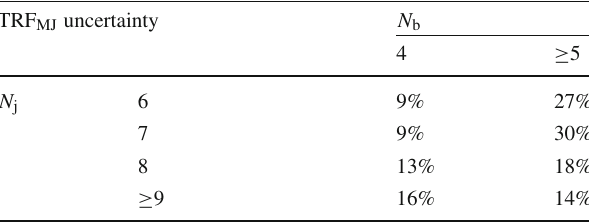
Table 2 Systematic uncertainties in the data-driven estimation of the multijet background using the TRF MJ method. The uncertainties are assessed using Pythia8 MC dijet events for each value of jet multi- plicity ( N j ) and b -tagged jet multiplicity ( N b ) used in the final fit TRF MJ uncertainty N